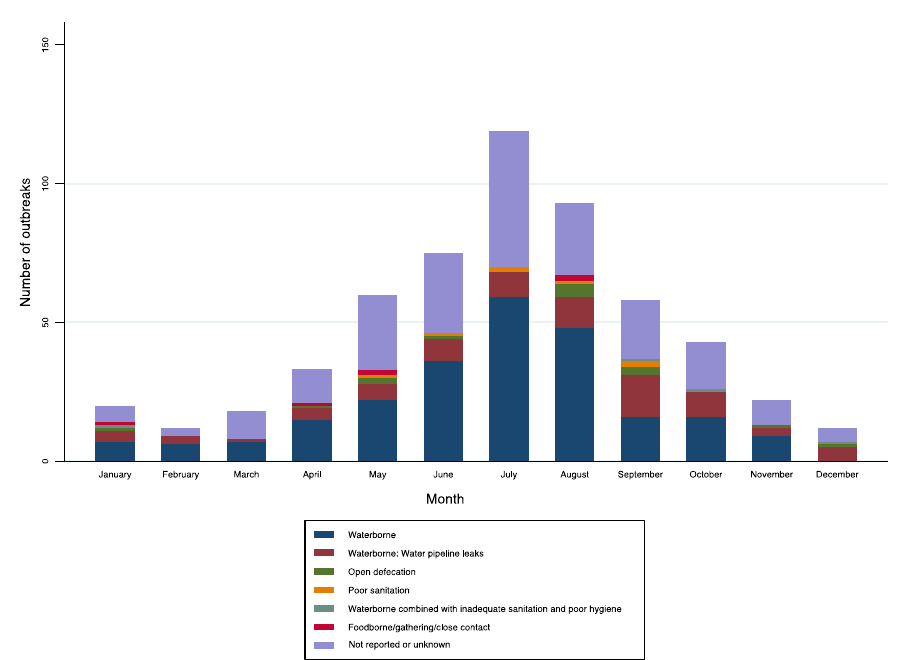
Figure 8. Number of cholera outbreaks ( n = 565) by month and transmission routes, India, 2011– 2020.